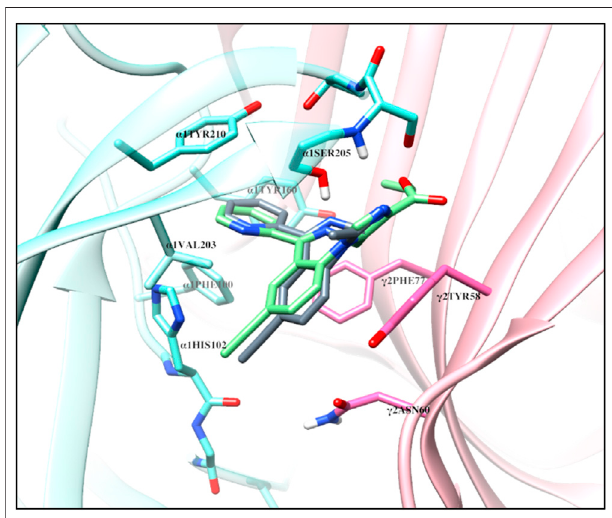
FIGURE 9 | The overlap of the docked con fi rmation of SH-TRI-108 and HZ-166 in the complex with α 1 β 3 γ 2L GABA A receptor 6HUO at the α + γ −